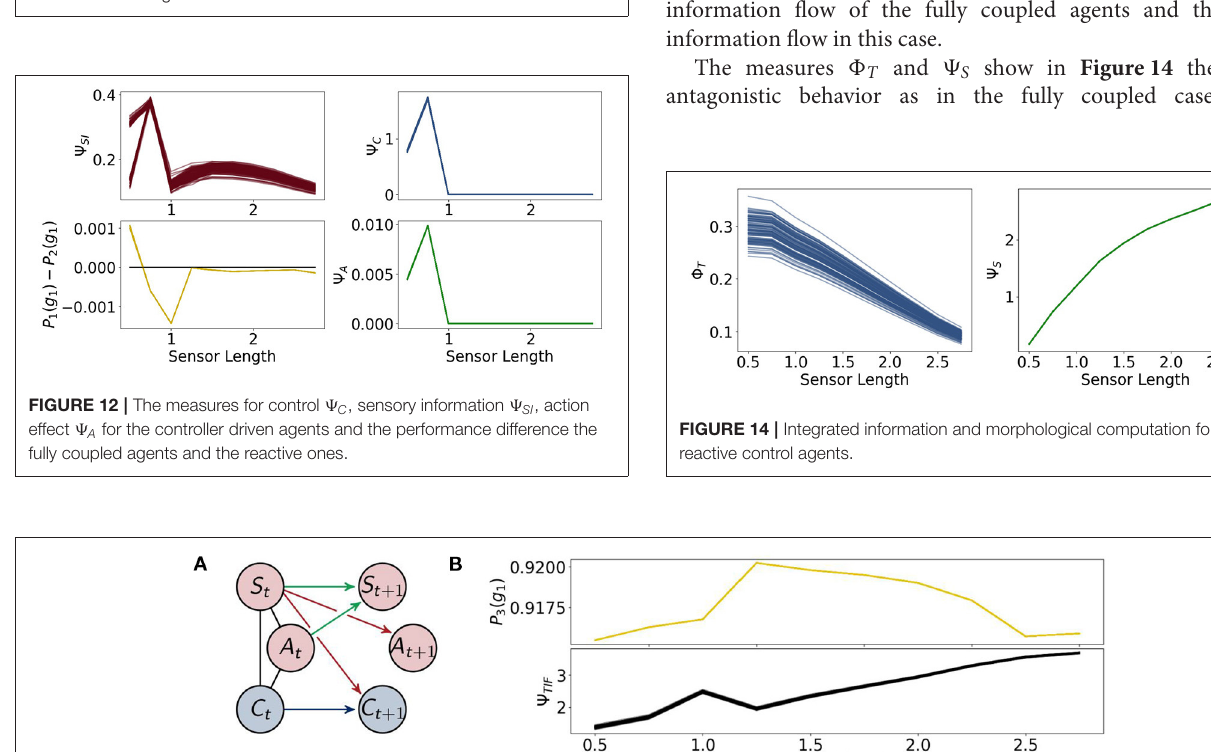
FIGURE 11 | Integrated information and morphological computation for the controller driven agents.